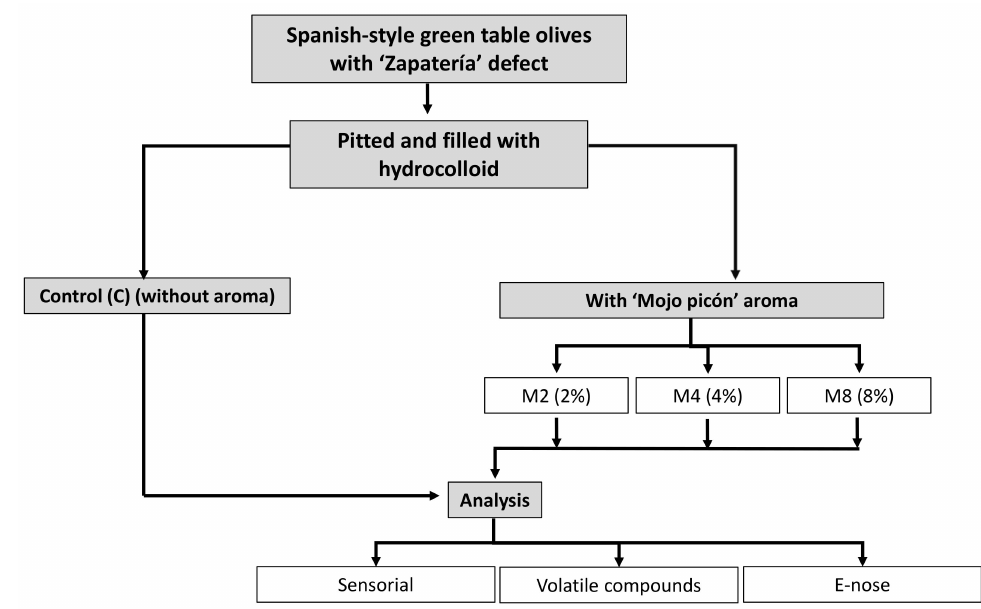
Figure 3. Diagram of the experimental